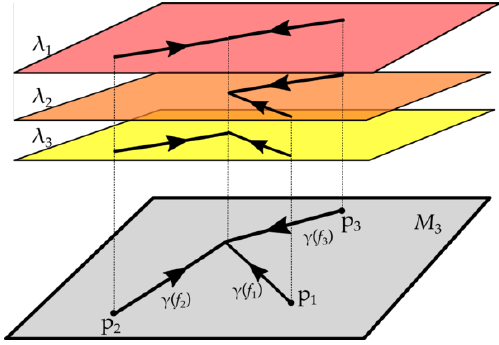
Figure 8 . Construction of three-cycle that gives rise to the Yukawa couplings in the spectral Cover picture. The critical loci p i correspond to the loci where two of the weights (cid:21) j are equal, i.e. the corresponding sheets of the spectral cover meet. The uplift of the gradient (cid:13)ow lines (cid:13) ( f i ) sweeps out the associative three-cycle S 3 that can then be wrapped by an M2-instanton. This gives rise to the coupling between the three matter states localized at (cid:21) i = 0. The combined (cid:13)ow lines give rise to the gradient (cid:13)ow tree (cid:13) ( f 1 ; f 2 ; f 3 ).